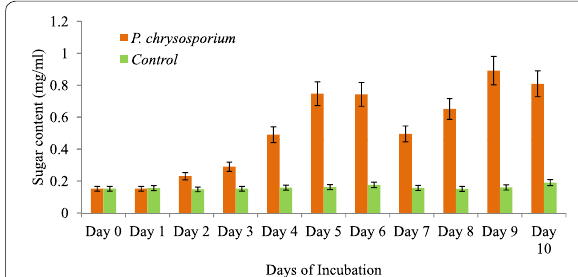
Fig. 1 Reducing sugar content during pretreatment of wheat straw by P. chrysosporium